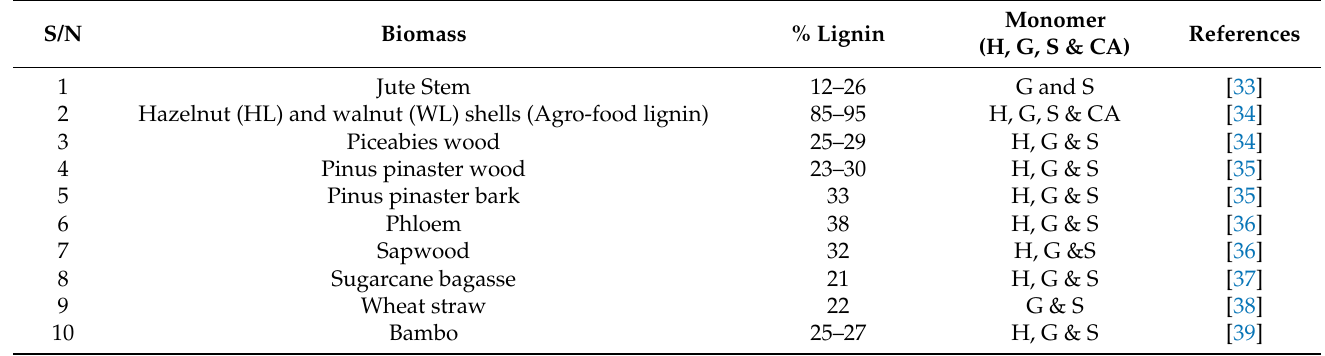
Table 1. Sources of Biomass with percentage composition of lignin and monomers.